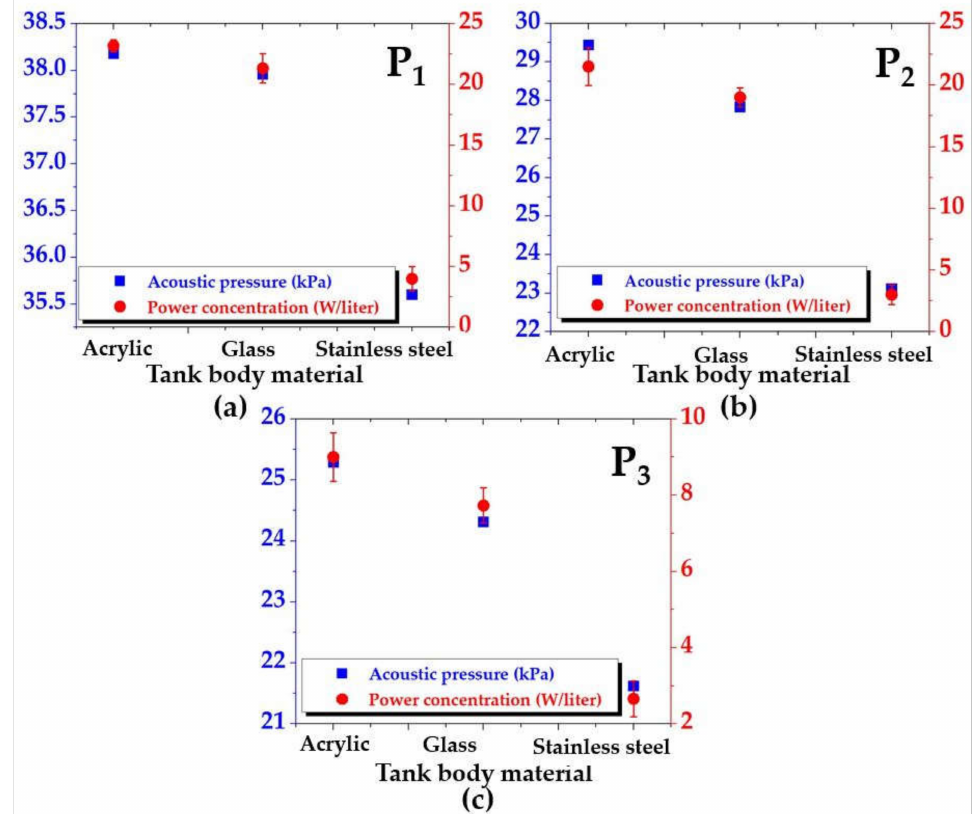
Figure 10. Comparison between the acoustic pressure and power concentration for tank bodies made of acrylic, glass, and stainless steel at positions ( a ) P 1 , ( b ) P 2 , and ( c ) P 3